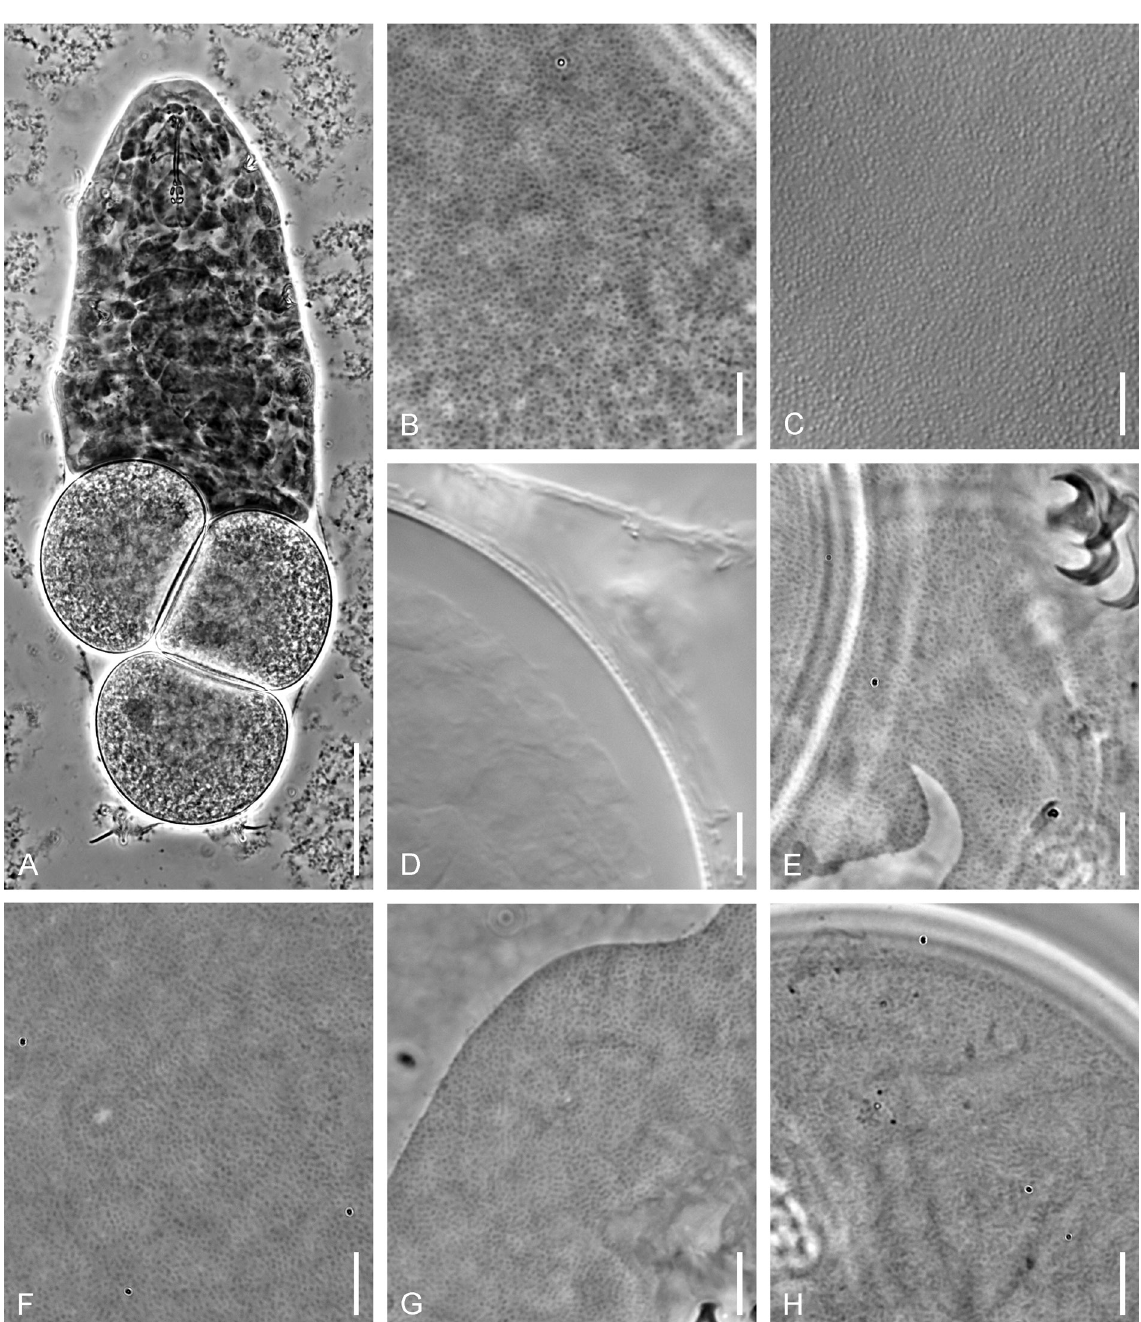
Fig. 7. A–G. Hypsibius pallidoides Pilato, Kiosya, Lisi, Inshina & Biserov, 2011 eggs. A–D, specimen KNU Чер-9 II. A . Type series specimen mounted during the egg laying process, PhC. B . Type series egg shell, PhC. C. Type series egg shell, DIC. D . Type series egg shell structure with numerous internal pillars visible, DIC. E . Austrian population egg shell (SPbu 251(3)), PhC. F . Karelian population egg shell (SPbu 113(2)), PhC. G . Pushkin population egg shell (SPbu 235(28)), PhC. – H . Pilatobius recamieri (Richters, 1911), egg shell (SPbU 203(7)), PhC. Scale bars: A = 50 µm; B–H = 5